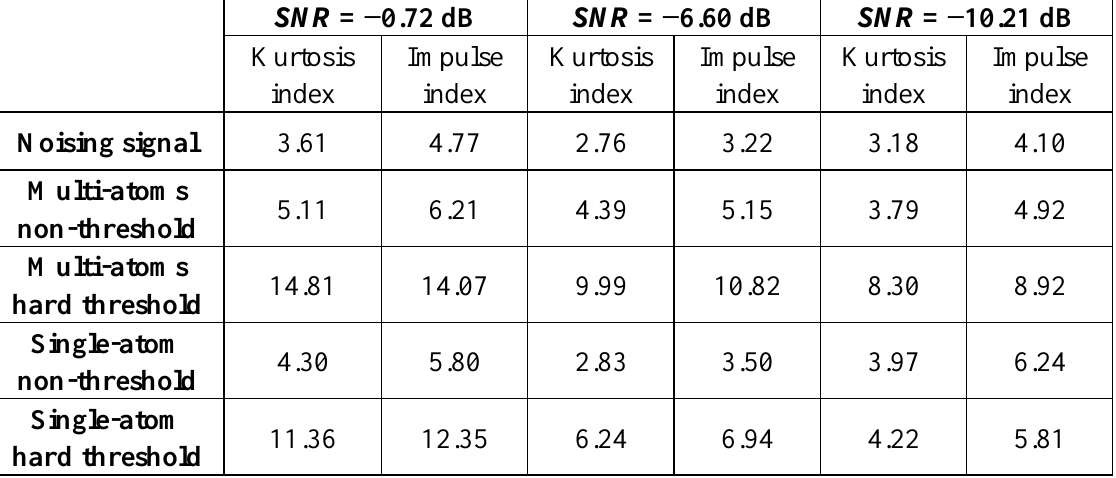
Table 2. Influences of noise intensity on the effects of impulse signal extraction with multi-atoms matching or single-atom